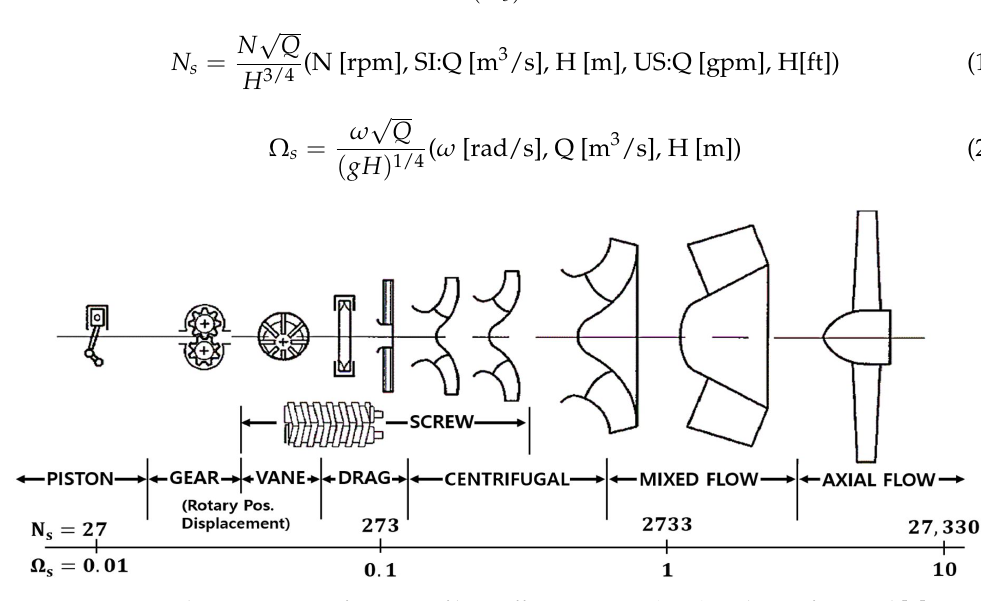
Figure 1. Optimal geometry as a function of best efficiency point(BEP) and specific speed